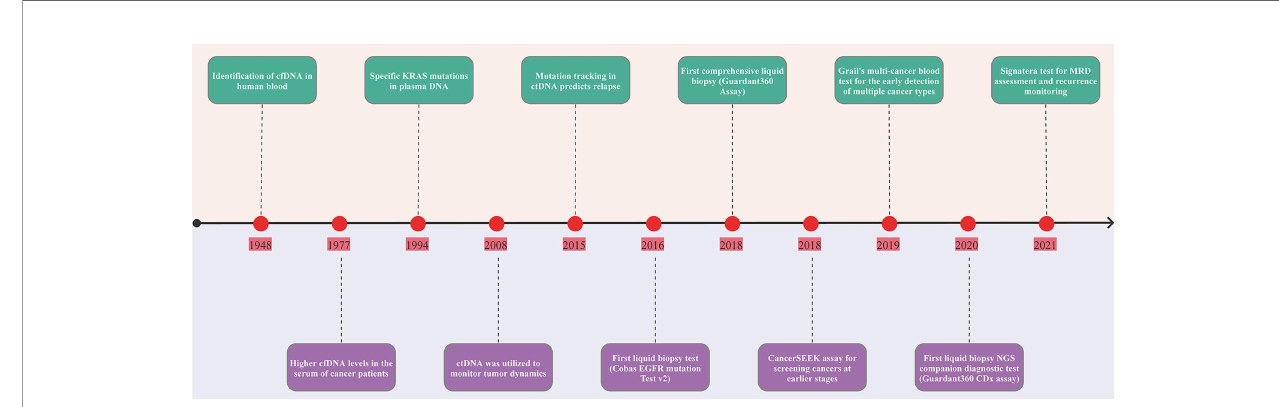
FIGURE 1 | Timeline of the landmark in ctDNA analysis. The fi gure exhibits a timeline of selected signi fi cant milestones in ctDNA as applied to solid tumors. FDA, The United States Food and Drug Administration; MRD, minimal residual disease; ctDNA, circulating